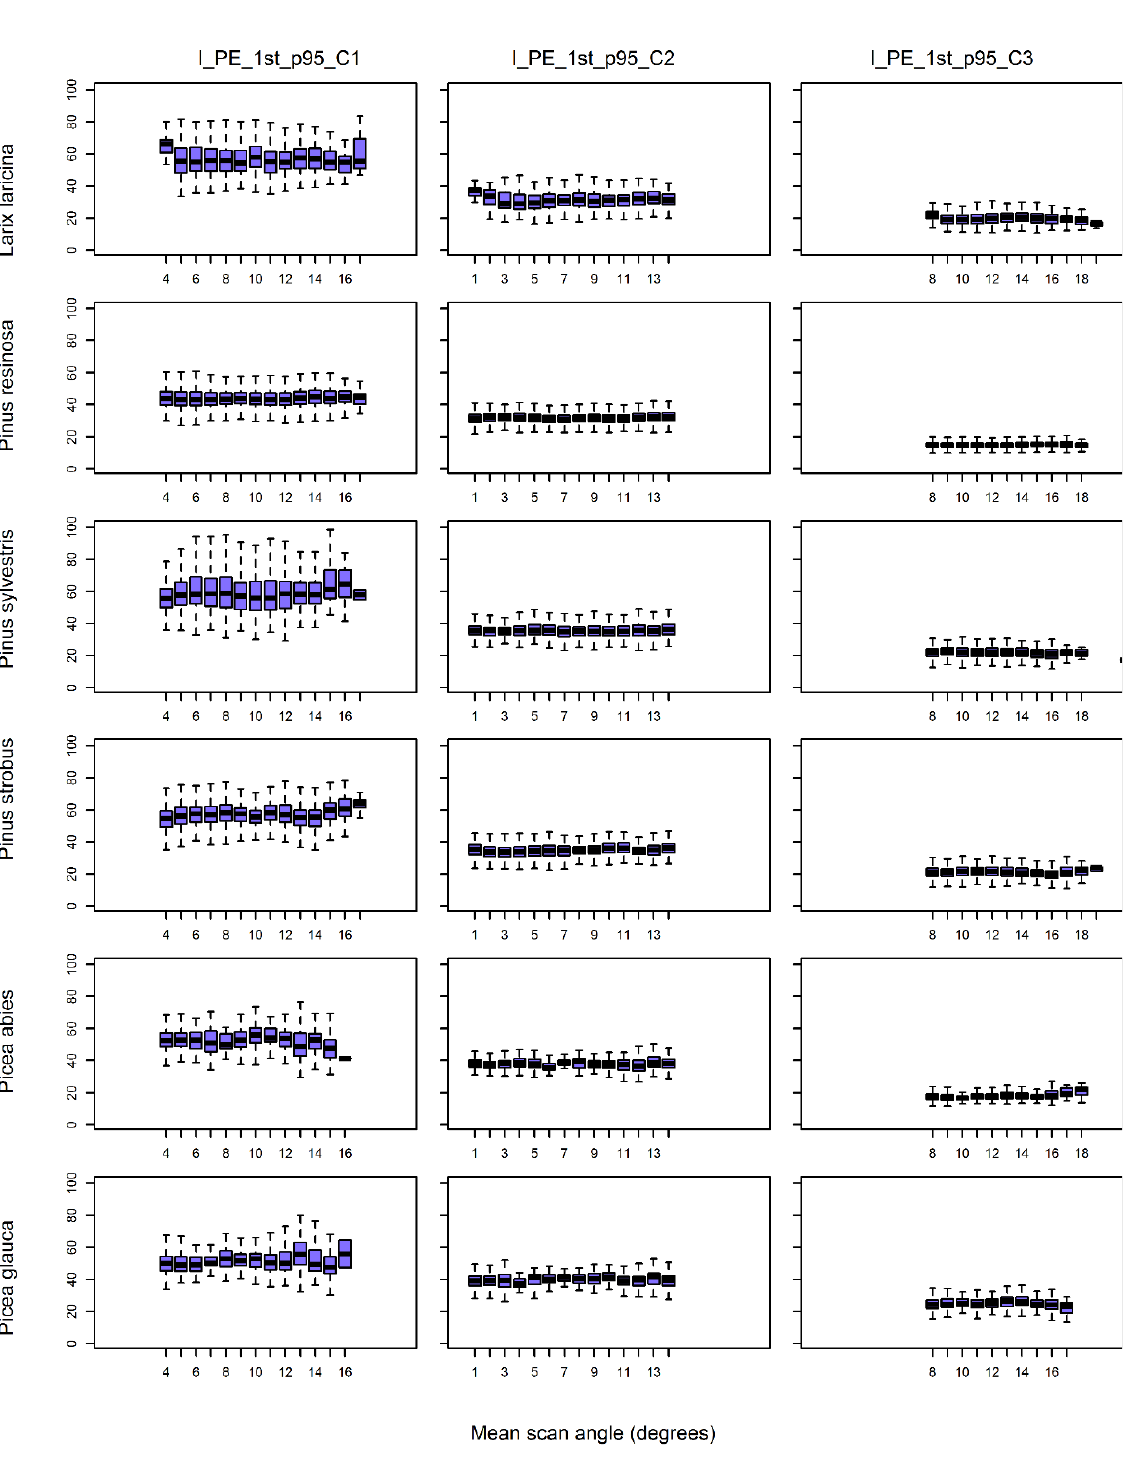
Figure 6. Variations in the feature I_PE_1st_p95 (95th percentile of the normalized intensity of the first returns in each of the three channels) according to scan angle, and per species.